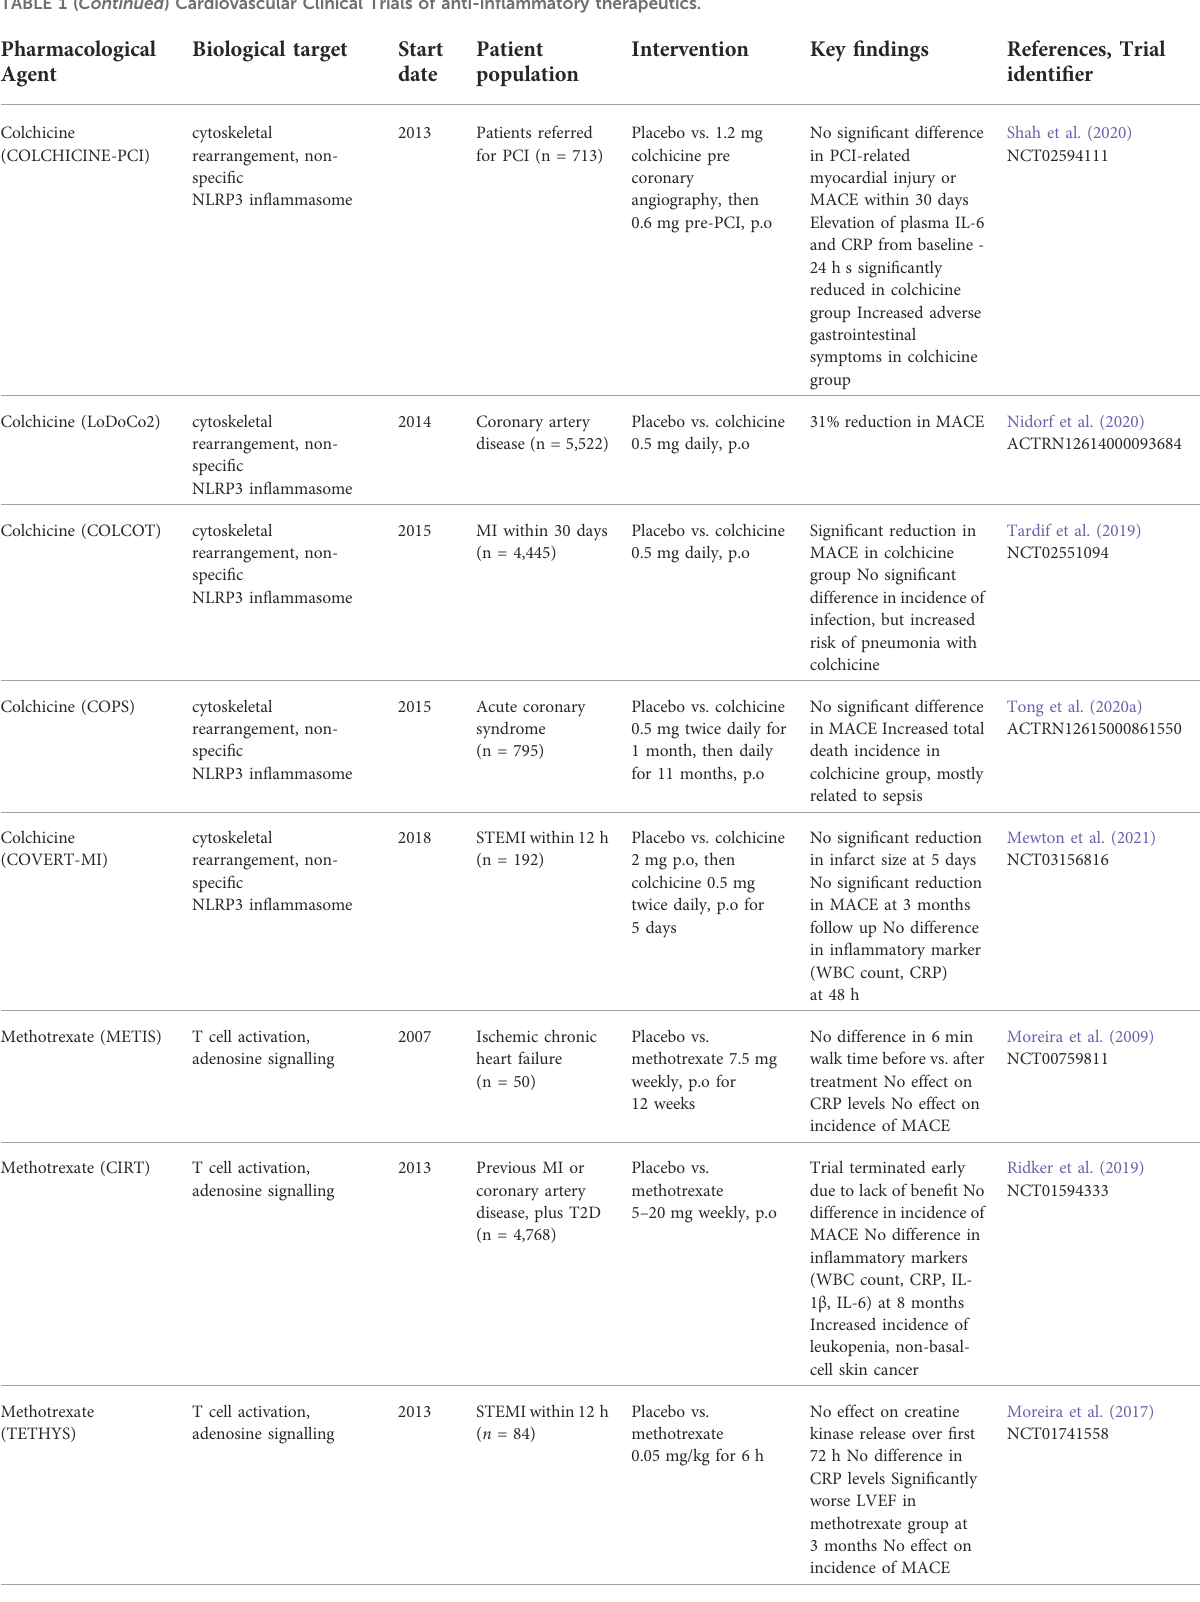
TABLE 1 ( Continued ) Cardiovascular Clinical Trials of anti-in fl ammatory